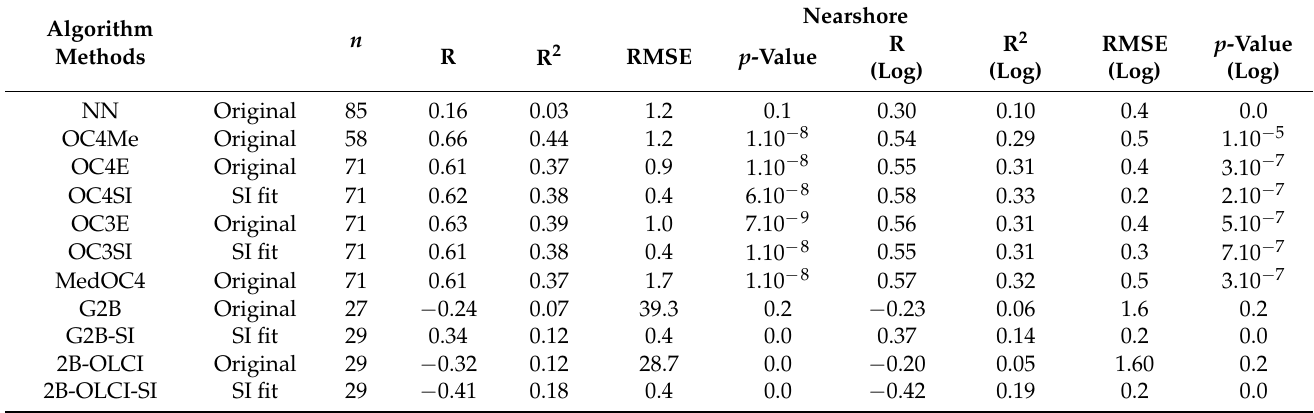
Table 2. Statistical analysis (R, R 2 , RMSE and p-value) for the original (OC4Me, NN, OC3E, OC4E, MedOC4, ADOC4, AD4, 3B-OLCI, 2B-OLCI and G2B) and recalibrated (OC4SI, OC3SI, AD4SI, G2B-SI, 2b-OLCI-SI, 3B-OLCI-S) Chl- a algorithms at nearshore